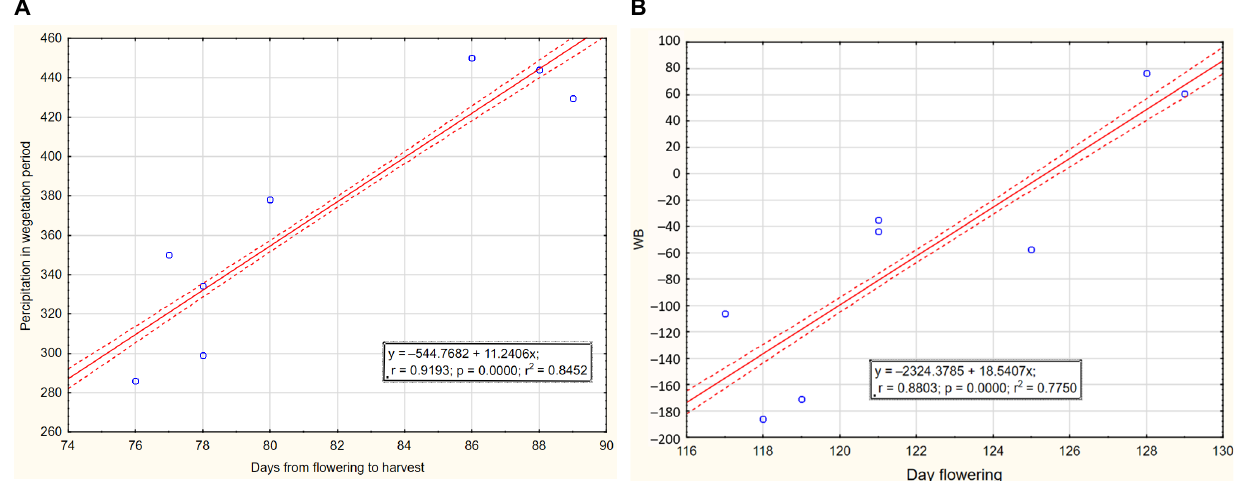
Figure 6. Relationship between: ( A )—total of rainfall and number of days between flowering and harvest date and ( B )—flowering date and water balance.